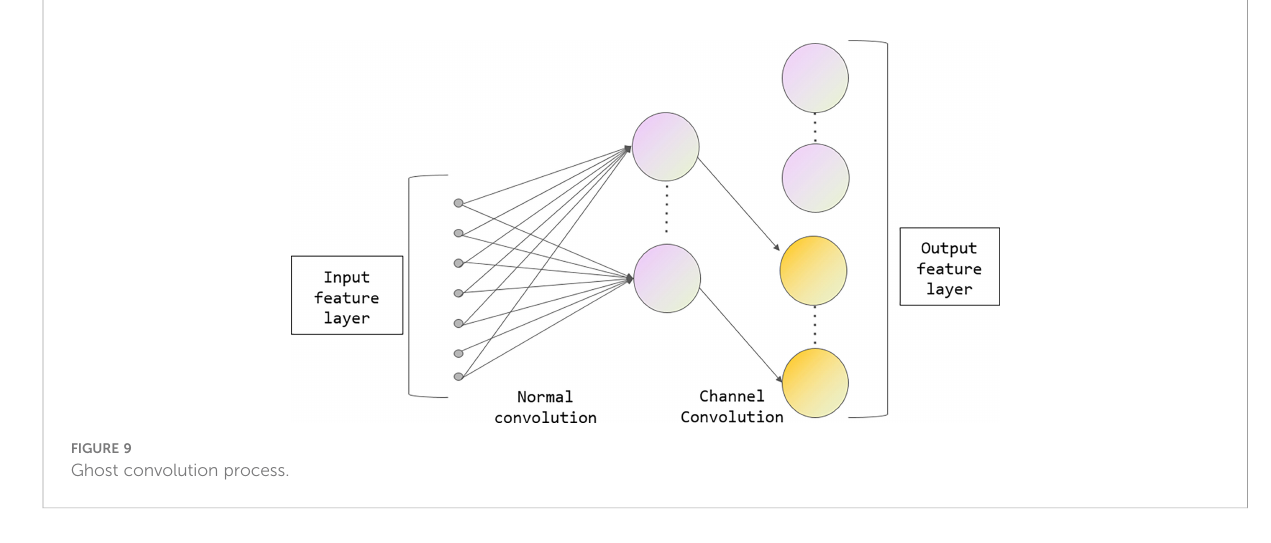
FIGURE 9 Ghost convolution